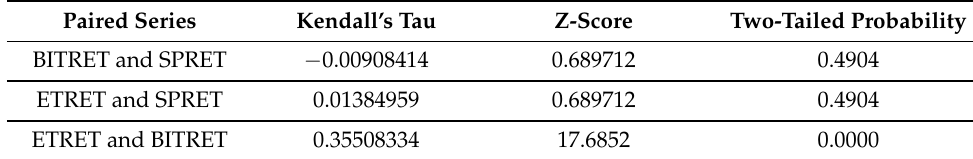
Table 5. Kendall’s tau measure of association among the return series in Period